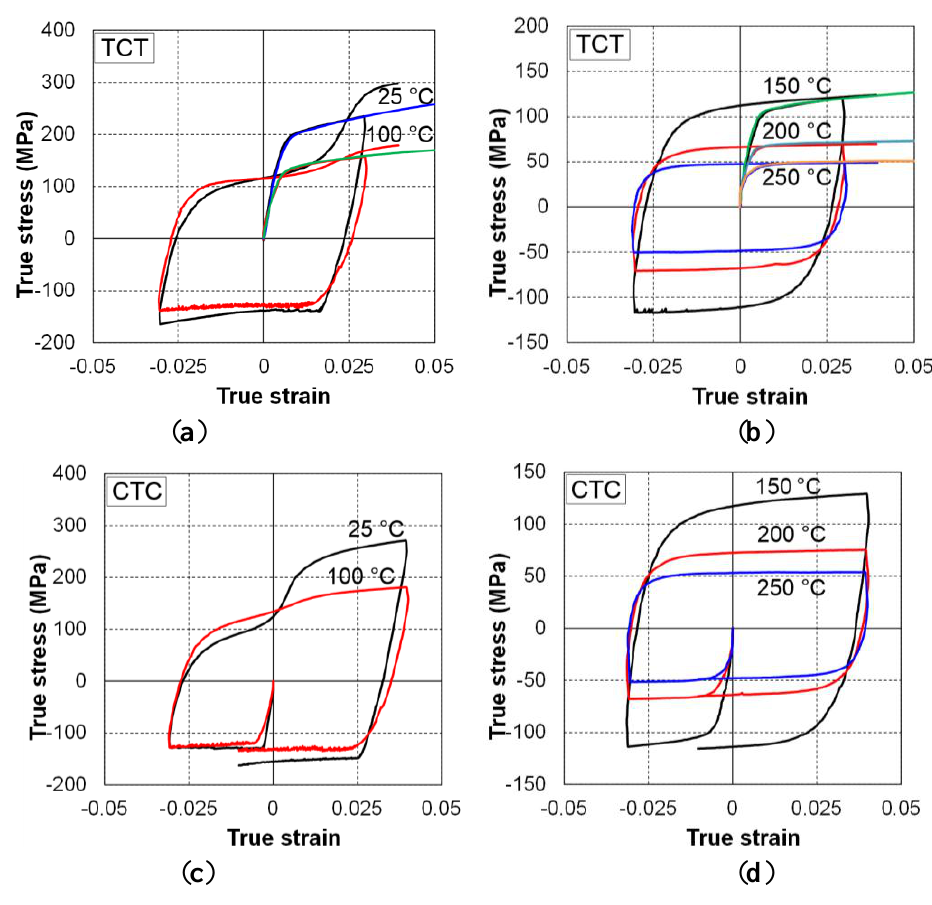
Figure 17. Uniaxial tension-compression-tension (TCT) and compression-tension-compression (CTC) curves at different temperatures: ( a ) TCT at RT and 100 °C; ( b ) TCT at 150, 200 and 250 °C; ( c ) CTC at RT and 100 °C; ( d ) CTC at 150, 200 and 250